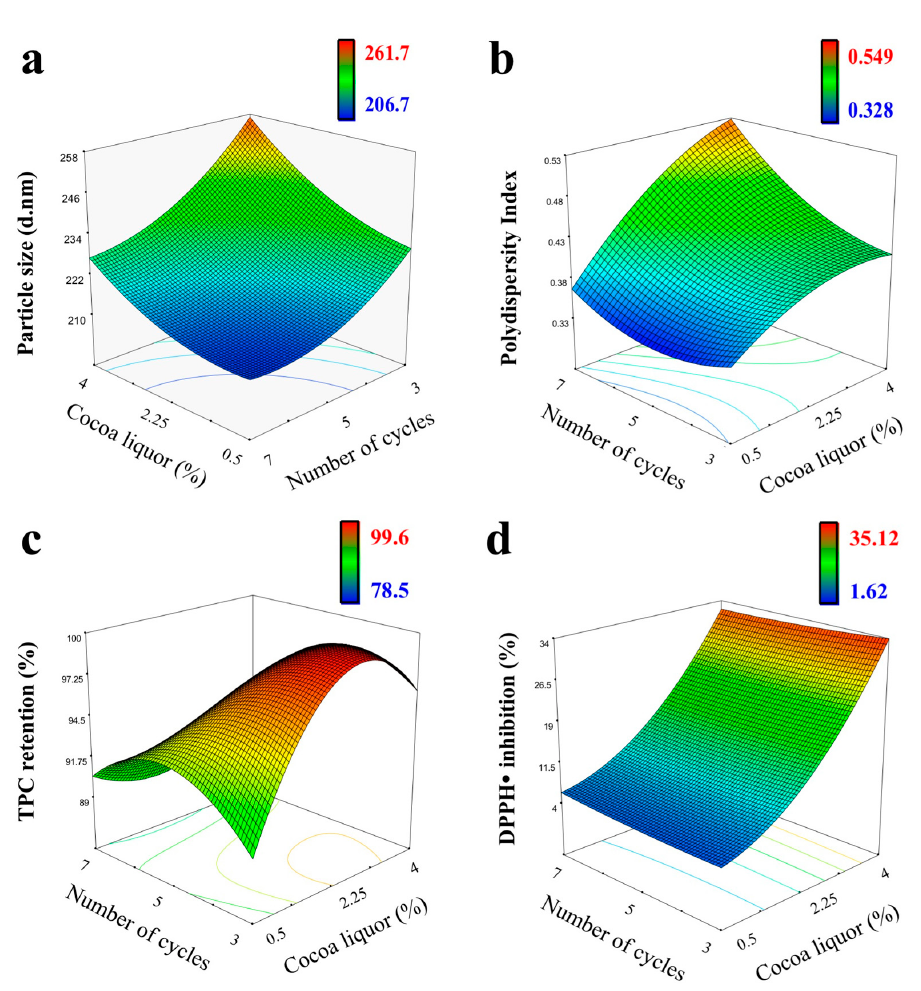
Figure 1. Three-dimensional response surface plot for the interactive effect of independent variables (cocoa liquor concentration and homogenization cycles) on: ( a ) particle size; ( b ) polydispersity index; ( c ) polyphenols retention; and ( d ) DPPH radical inhibition of the nanoemulsion with 8% of whey protein after microfluidization at 25,000 PSI (172.4 MPa).